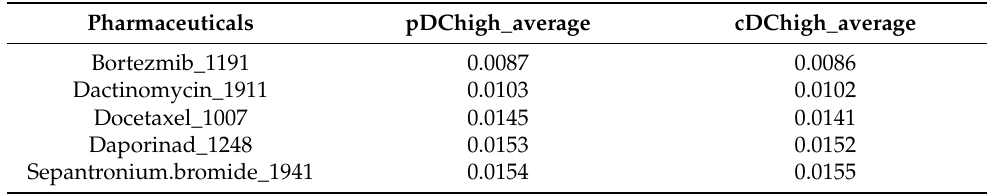
Table 3. Top five drugs with the lowest IC50 values for drug prediction outcomes in patients with a high abundance of pDCs and